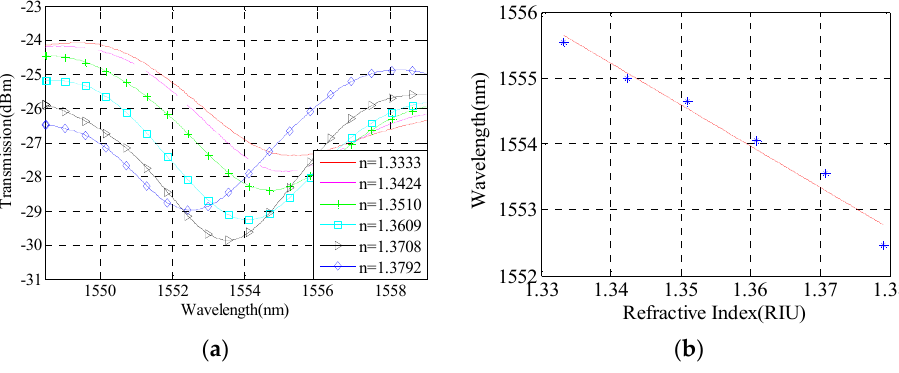
Figure 9. Sensitivity analysis with taper waist diameter of 24 μ m, taper distance of 5.5 cm, and taper area length of 837 μ m. ( a ) Interference spectrum; ( b ) Sensitivity of refractive index measurement.